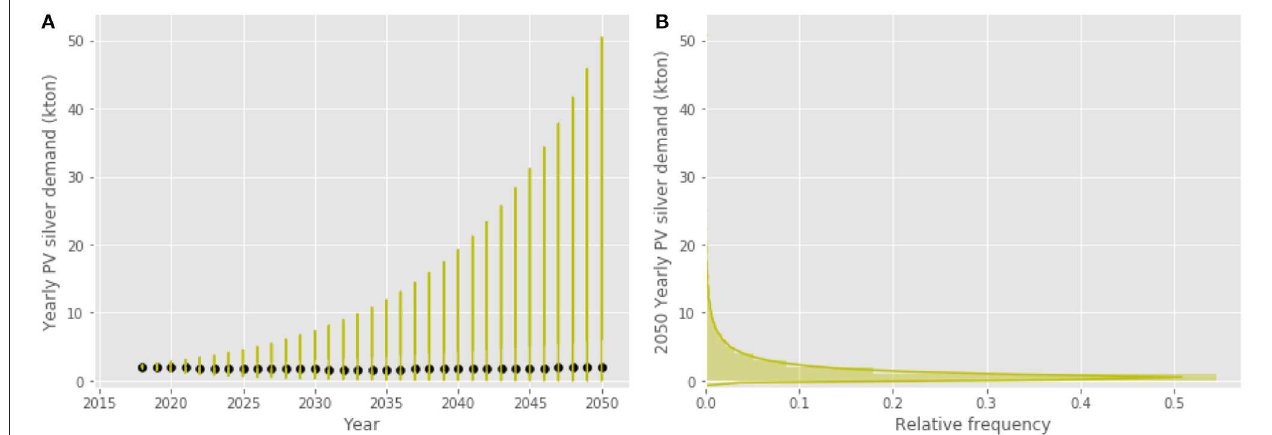
FIGURE 2 | (A) Yearly trend of silver demand for the photovoltaic sector (kiloton per year) over 2018–2050 according to the Monte Carlo simulations run on 8,192 quasi-random samples. The means of the yearly distributions are shown in black. (B) The distribution of the simulations outcome for the year 2050 (yearly silver PV demand against relative frequency).